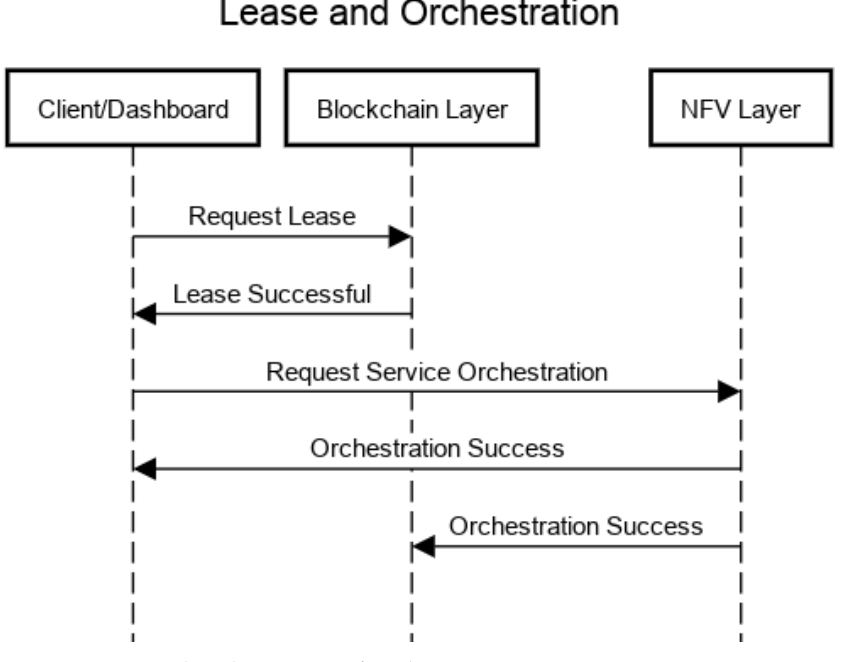
Figure 3. Lease and Orchestration